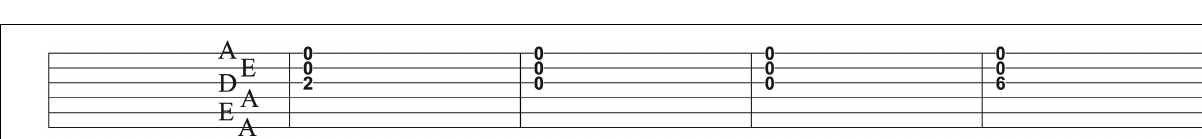
FIGURE 4 | Teacher and student searching for (A) and finding (B,C) a specific note.